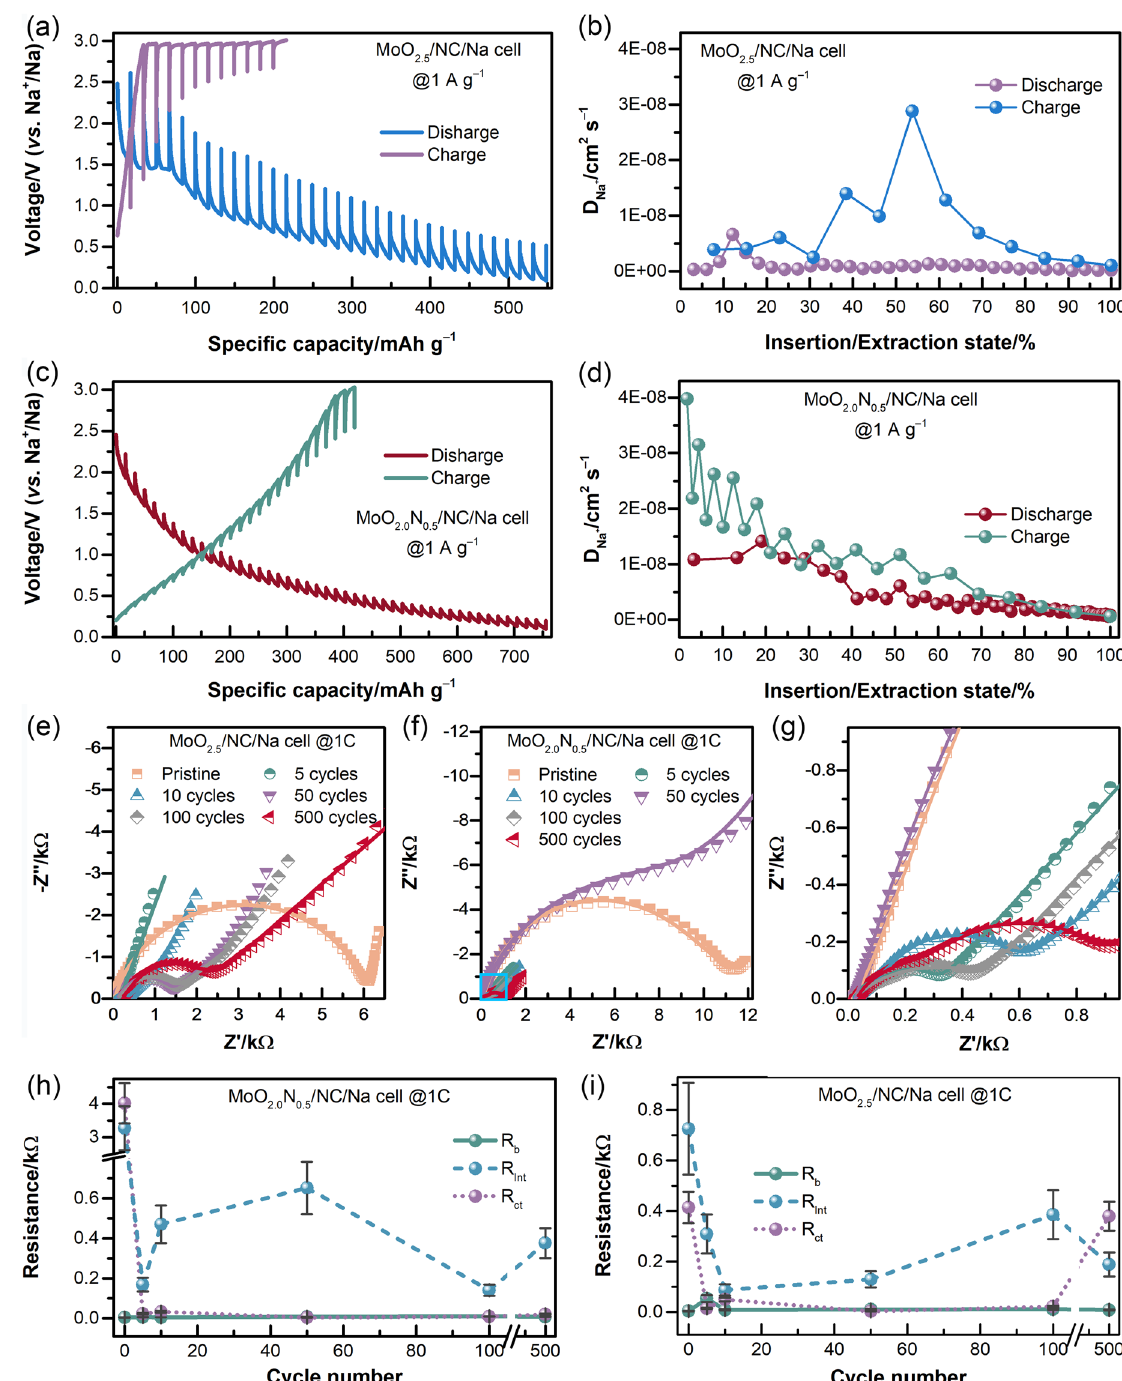
Fig. 6 GITT profiles (current pulse at 1 A g −1 for charging/discharging with 20 min relaxation) for a MoO 2.5 /NC and c MoO 2.0 N 0.5 /NC, and cor- responding sodium-ion diffusion coefficient of b MoO 2.5 /NC and d MoO 2.0 N 0.5 /NC electrodes. Nyquist plots of e MoO 2.5 /NC, f–g MoO 2.0 N 0.5 / NC; the resistance of the cells as functions of cycle number at 1 A g. −1 : h MoO 2.5 /NC, and i MoO 2.0 N 0.5